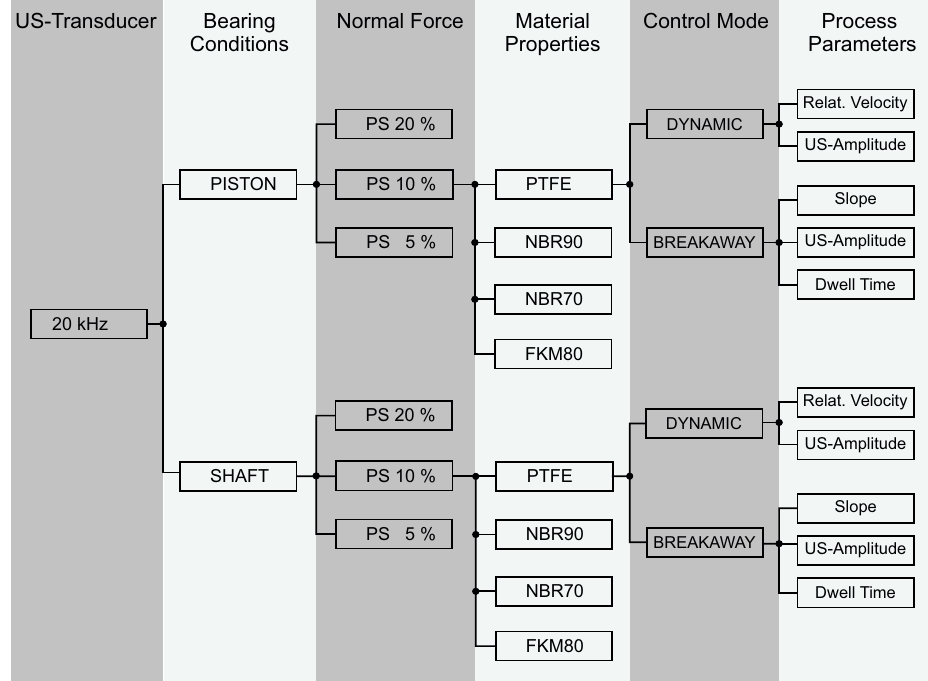
Figure 5. The parameter tree for the investigation of contact behavior induced by ultrasonic superpo- sition of 20